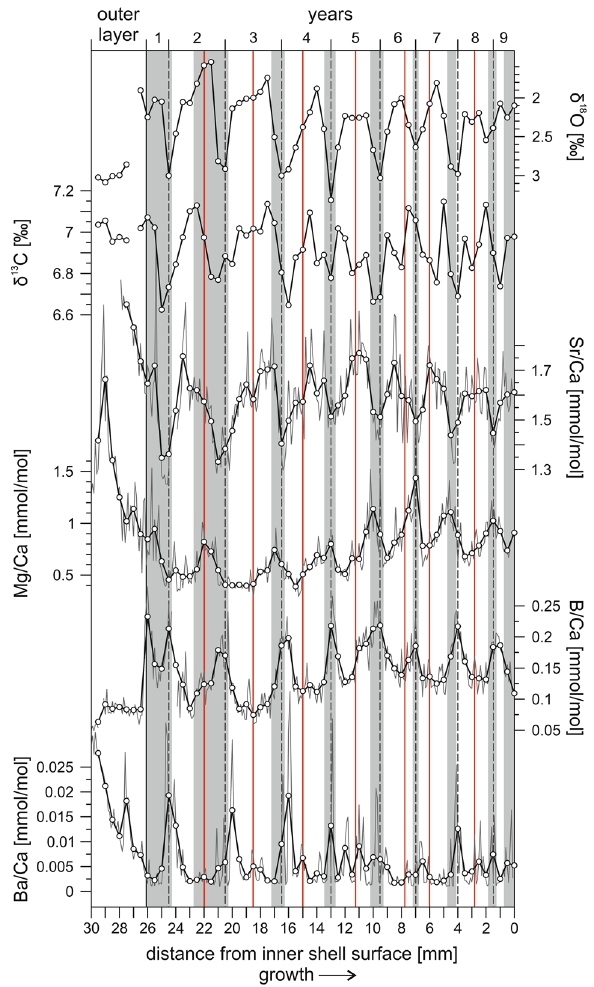
Figure 2. Seasonal variations in the stable isotope and element/Ca composition of T-Tiwi1. Data is plotted as a function of distance from the shell edge. The direction of growth is indicated towards the right (arrow) and most recently secreted layers of carbonate are at 0 mm. Sampled element/Ca data is represented by thin grey lines, with the thicker black line representing the 5 point moving average. Dashed vertical lines define years and vertical red lines indicate upwelling events as deduced from the δ 18 O and δ 13 C data. Vertical grey bars mark the position of dark growth bands as visible along the sampling paths in reflected light (Supplementary Fig.